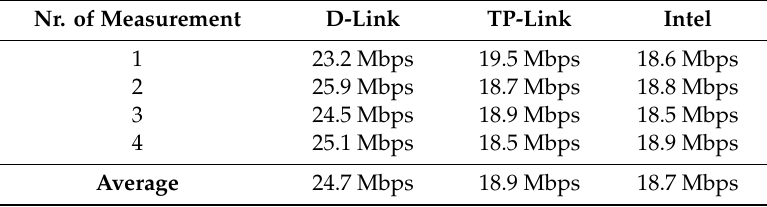
Table 3. Average maximum throughputs on three di ff erent wireless